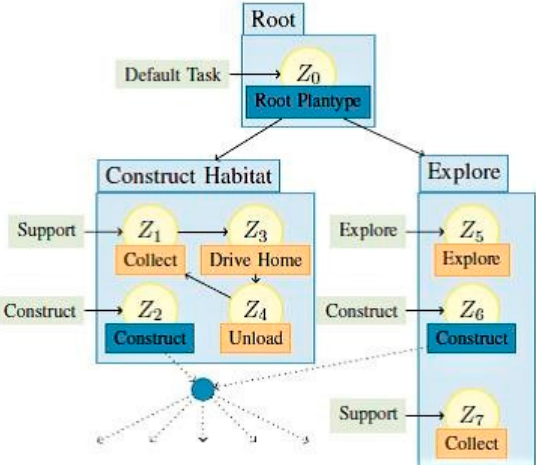
Figure 1. Example of ALICA (A Language for Interactive Collaborative Agents) program for an exploration.